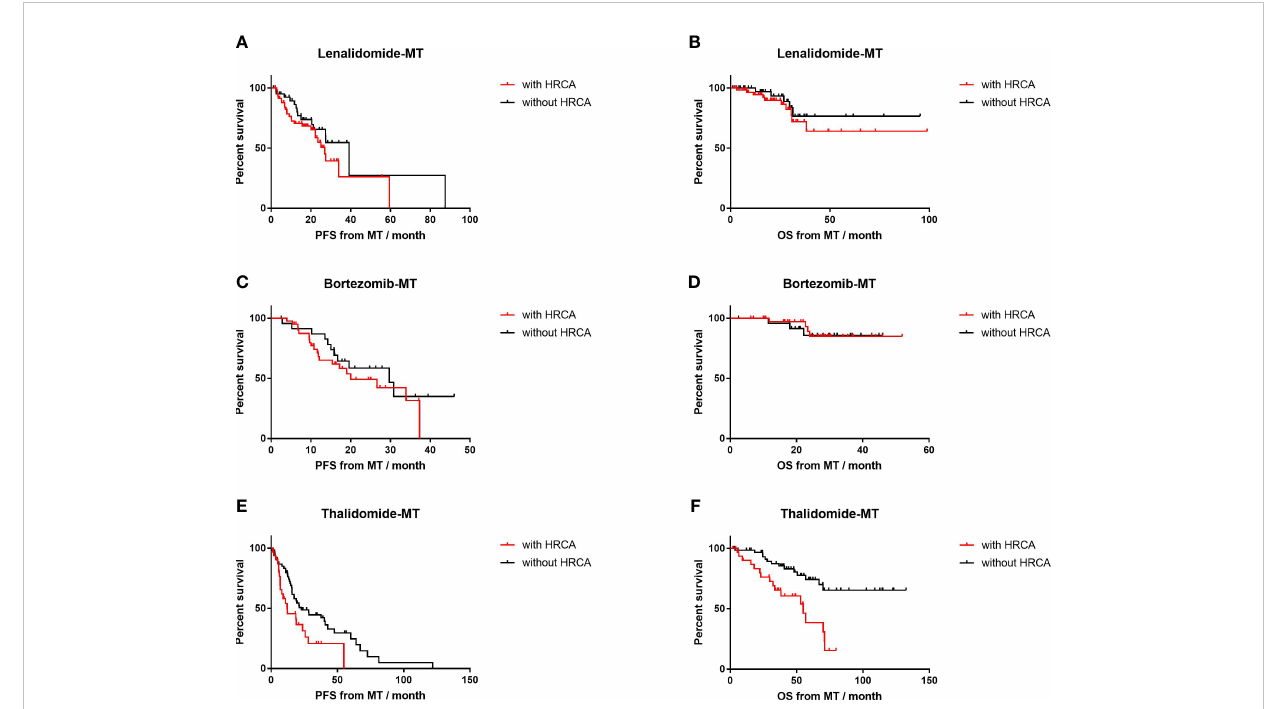
FIGURE 4 Impact of high-risk cytogenetics on progression-free survival (PFS) and overall survival (OS) of lenalidomide, bortezomib, and thalidomide maintenance. (A, B) The median PFS and median OS of patients with high-risk cytogenetics (n=60) versus those without (n=42) in patients on lenalidomide maintenance. (C, D) The median PFS and median OS of patients with high-risk cytogenetics (n=41) versus those without (n=25) in patients on bortezomib maintenance. (E, F) The median PFS and median OS of patients with high-risk cytogenetics (n=35) versus those without (n=62) in patients on thalidomide